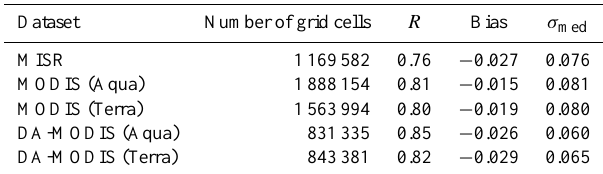
Table 3. Statistics of comparison between colocated SeaWiFS daily-averaged AOD at 550nm with that from other datasets. Only grid cells over land are considered. R is Pearson’s linear correla- tion coefficient between the grid-box average values. The bias is the median bias between the daily average values, defined such that positive values indicate SeaWiFS AODs are larger. The scaled me- dian absolute deviation of the difference between the two datasets is denoted σ med